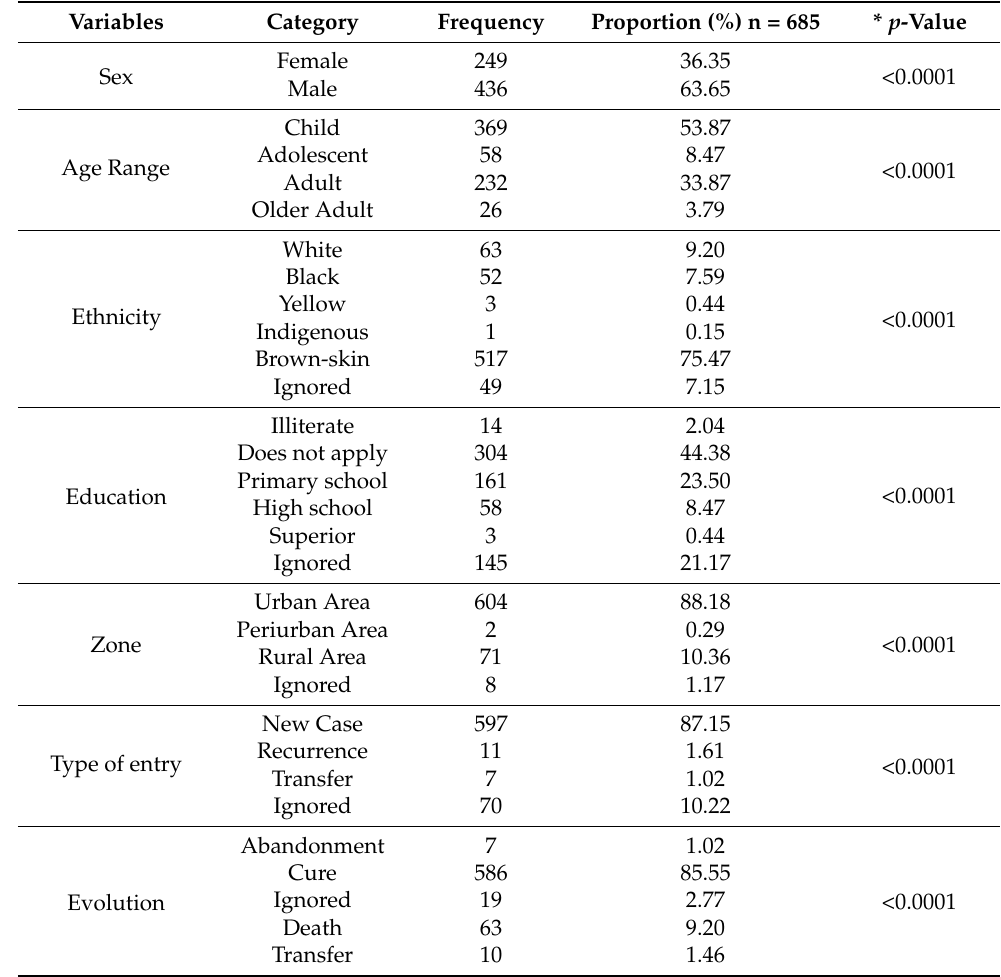
Table 1. Epidemiological profile of human visceral leishmaniasis in the Caraj á s Integration Region, Par á , Brazil, for the period of 2011 to 2020. Variables